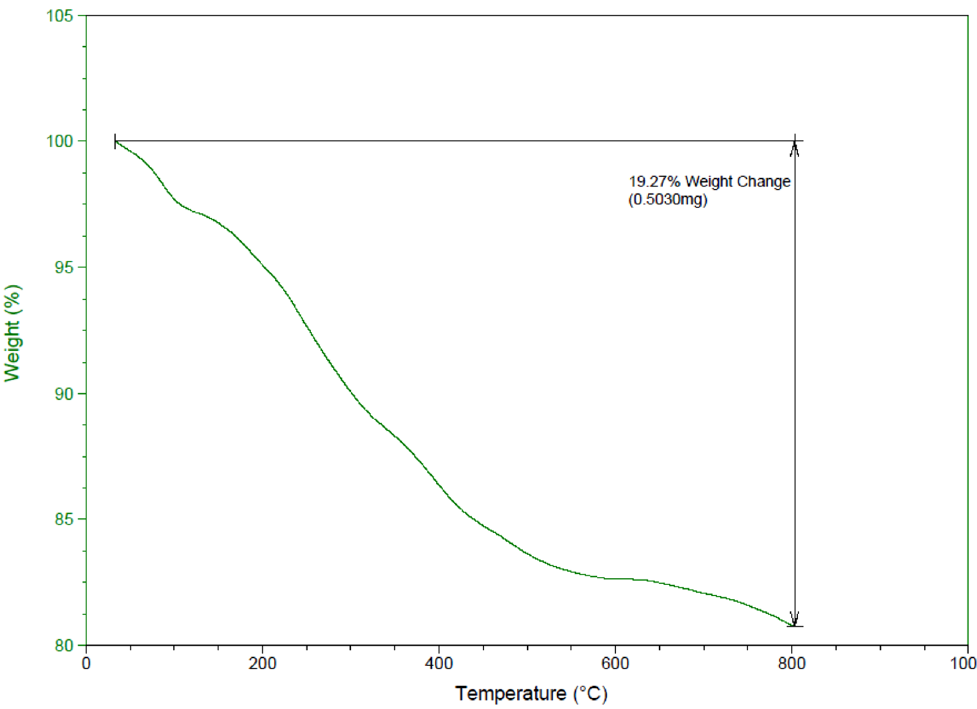
Figure 13. Thermogravimetric (TGA) analysis of MIL-53(Al)-N(CH 2 PO 3 H 2 ) 2